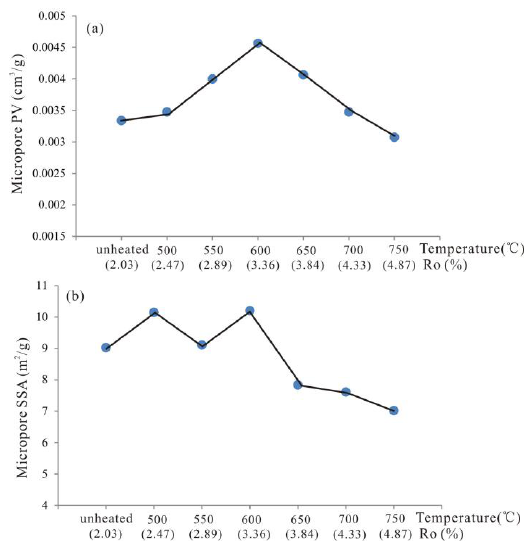
Figure 2. ( a ) Relationships between micropore pore volume (PV) and temperature (%Ro), ( b ) relationships between micropore specific surface area (SSA) and temperature